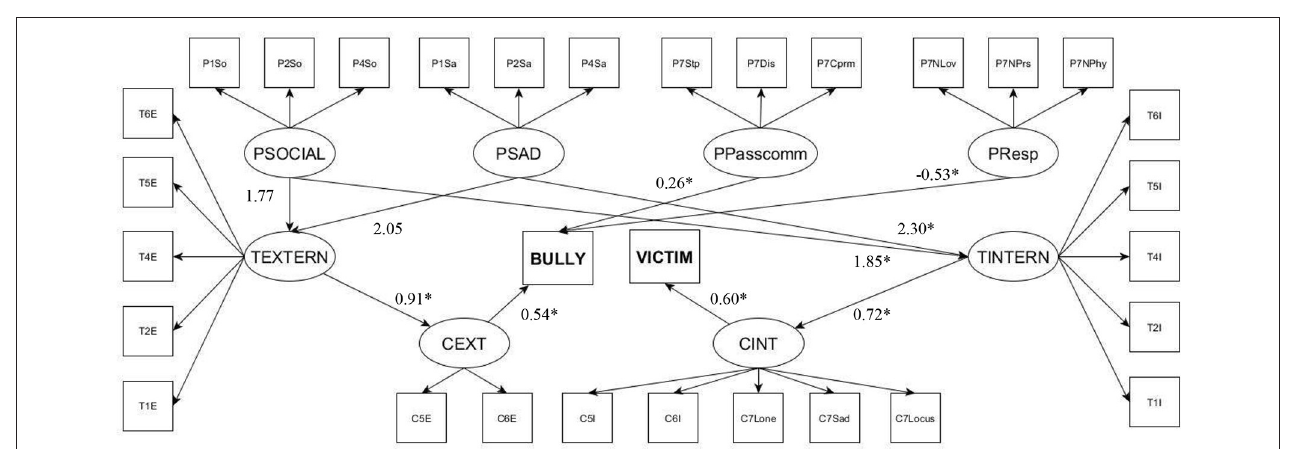
FIGURE 1 | Measurement model. All factors were correlated. Factor correlations and error variances are not shown.